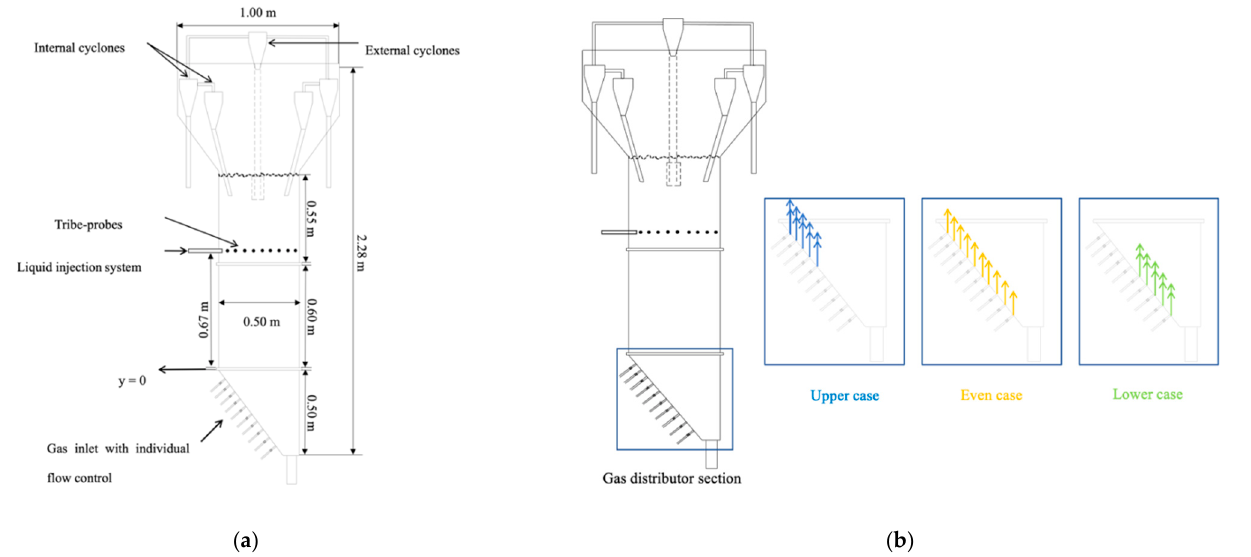
Figure 1. ( a ) Lab ‐ scale bubbling fluidized bed; ( b ) Different gas inlet distributor configurations. Figure 1. ( a ) Lab-scale bubbling fluidized bed; ( b ) Different gas inlet distributor